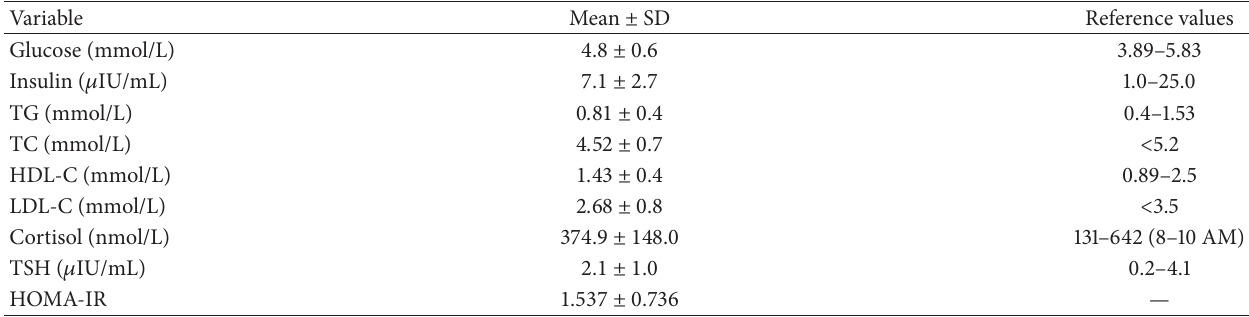
Table 2: Biochemical variables of the 87 subjects.